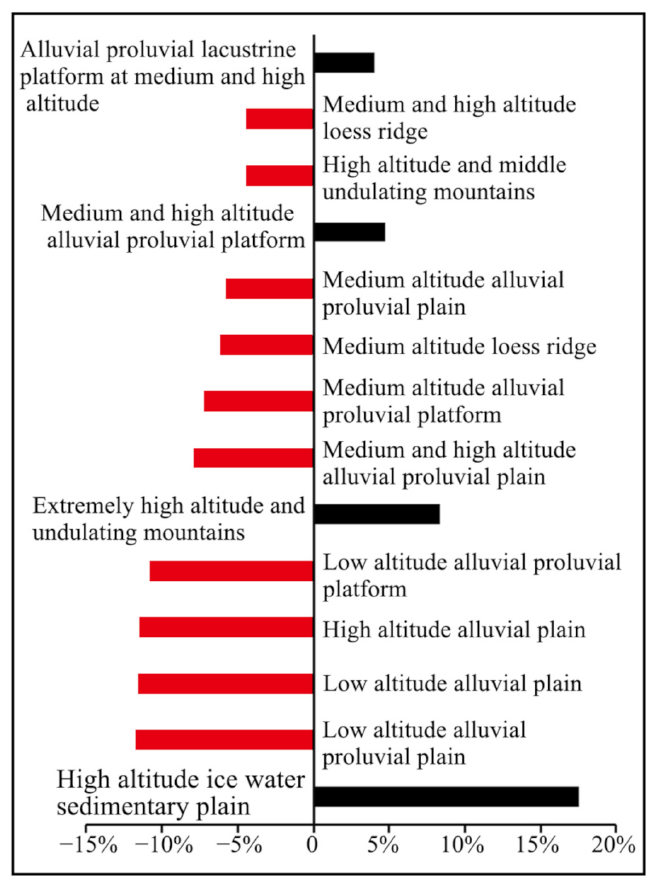
Figure 6. Top 14 geomorphic areas of cultivated land area change from 2010 to